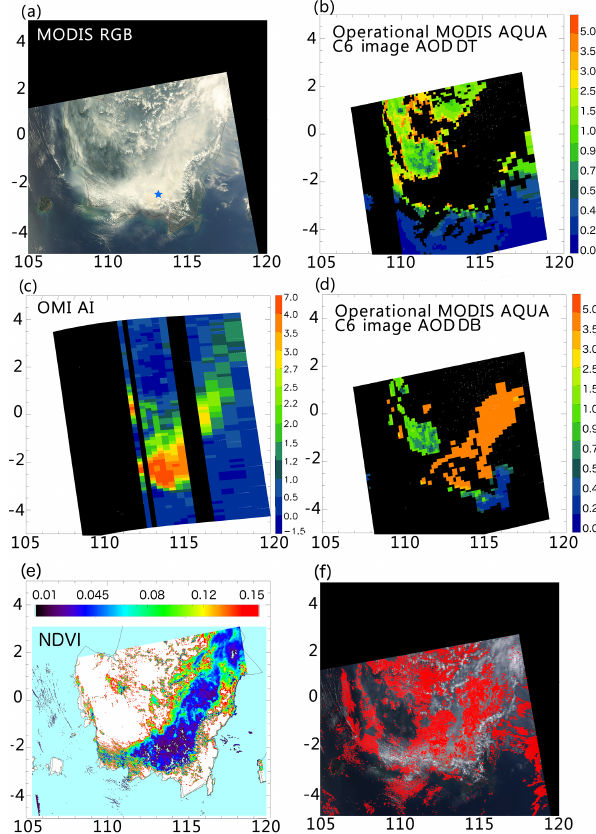
Figure 2. A case study of a fire in Kalimantan on the island of Borneo in Indonesia on 22 September 2015. (a) RGB image, (b) MODIS DT operational image AOD, (c) OMI AI, (d) MODIS DB all available AOD, (e) NDVI value, and (f) cloud product diag- nostic flags taken from the MODIS cloud optical properties product. In (e) NDVI values smaller than 0.01 are shown in light aqua and values greater than 0.15 are shown in white. In (f) the red denotes pixels where the cloud product has failed. These are overlain on top of the MODIS true color image. The blue star represents the AERONET site